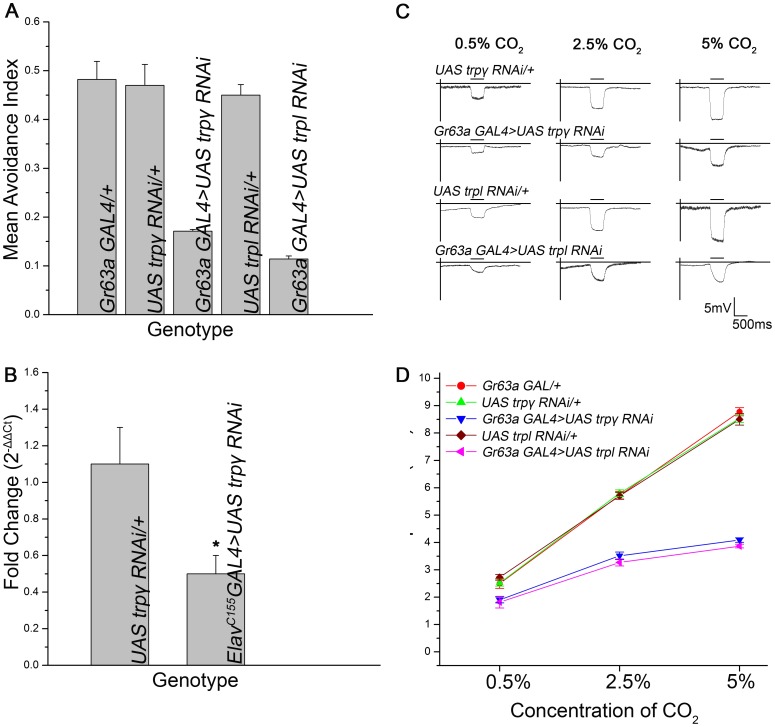
Down regulation of trpl and trpγ in CO2 receptor neurons results in reduced sensitivity to CO2 as observed in the responses from the Y-maze behavioral assay with 5% CO2 in A (p<0.0001).B) qRT-PCR data showing the fold change of trpγ gene expression in the UAS trpγ RNAi line relative to its control as determined by the comparative ΔΔCt method (N = 6; p<0.05). C) Representative traces of field recordings obtained as described above. Individual genotypes are indicated. D) Quantification of the field recordings for the genotypes tested (n = 10; p<0.0001). Error bars indicate SEM.